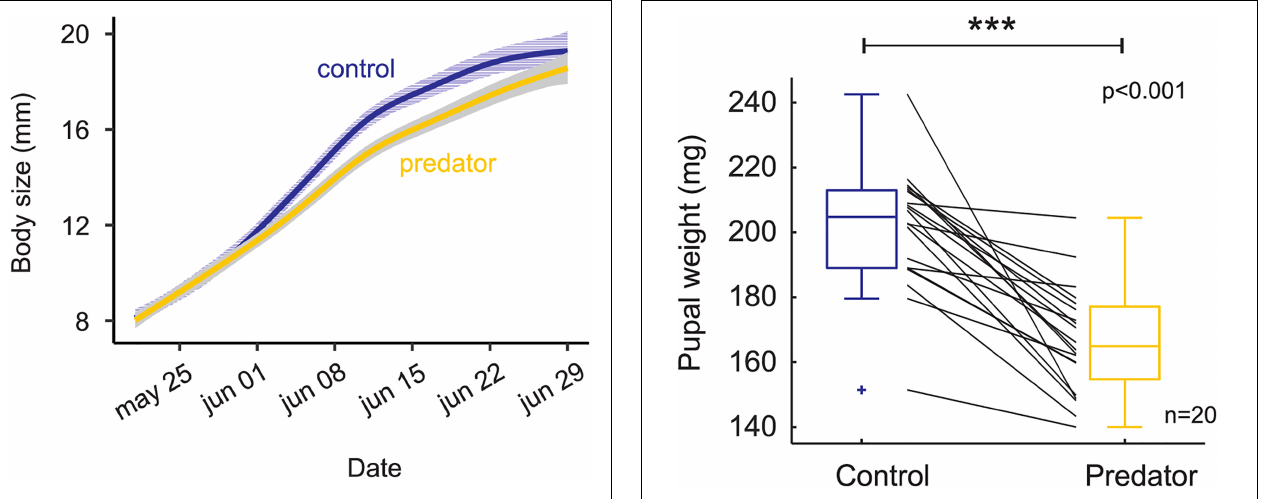
FIGURE 4 | Larval growth rate based on raw data.